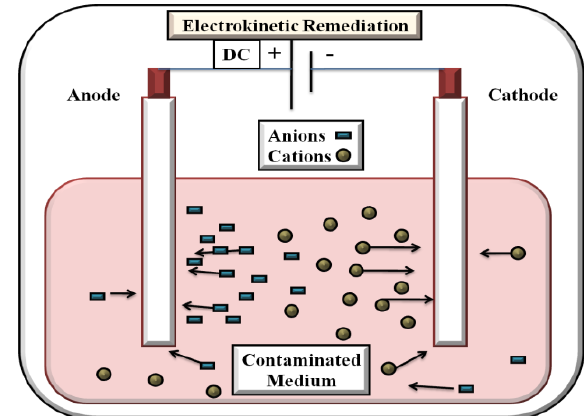
Figure 4. The electro-remediation of